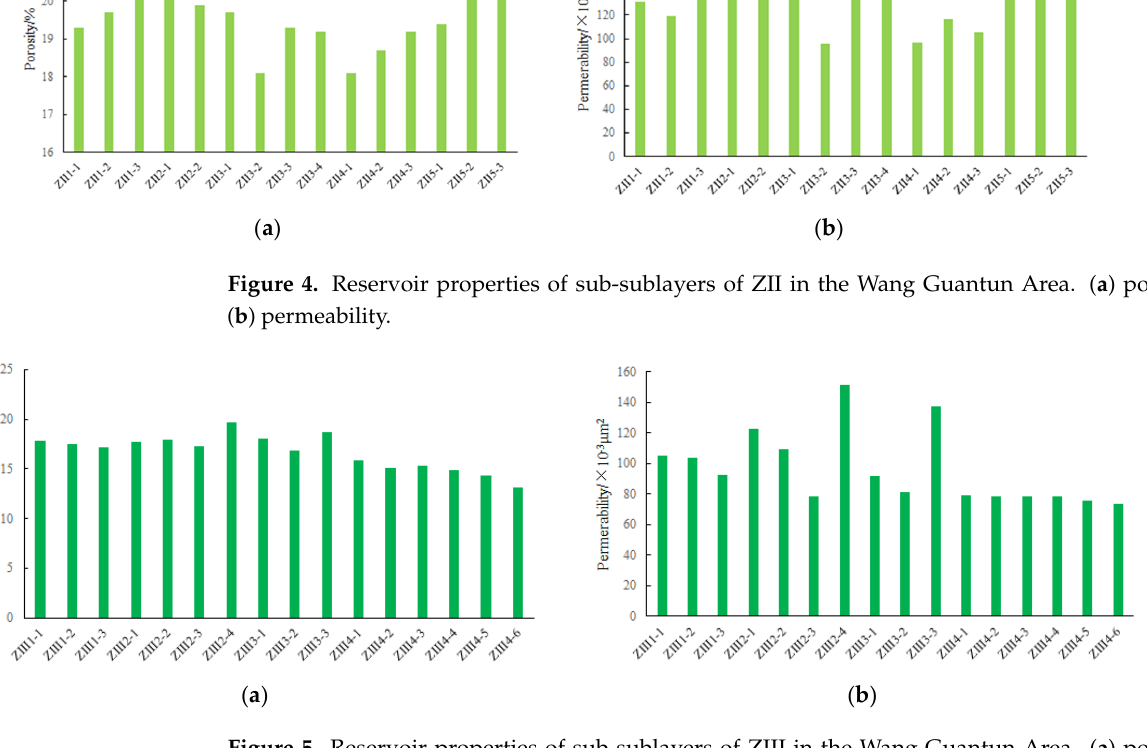
( f ) Figure 6. Pore types of reservoirs of Ek1 Formation in the Wang Guantun area. ( a ) Intergranular pore; ( b ) Intergranular dissolution pore; ( c ) Intergranular dissolution pore; ( d ) Mold pore; ( e ) Solu- tion pores in feldspar; ( f ) Microcracks. The number of residual intergranular pores was more in Ek1 formation in the Wang Guantun area, and its pore connectivity was good. Their shapes were often triangular, rectangular, and irregular polygons. The secondary pores were mostly dissolution pores. In the process of hydrocarbon expulsion from source rocks, a large amount of organic acids entered the Ek1 member. Feldspar and rock cuttings were dissolved by organic acids to form dissolution pores. A small number of particles were completely dissolved by acid fluid to form the casting pores. The dissolution pores were irregular in shape, random in distribution and poor in connectivity. The radii of the dissolution pores were generally 5~1000 μm. There were also some pores in clay minerals. These pores were very small and called intercrystalline pores. In addition, there were still a small number of micro-fractures